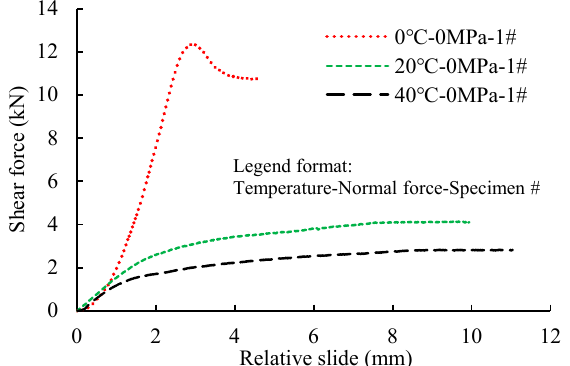
Figure 8. Shear force-relative slide relationship of with separator layer at different temperature.